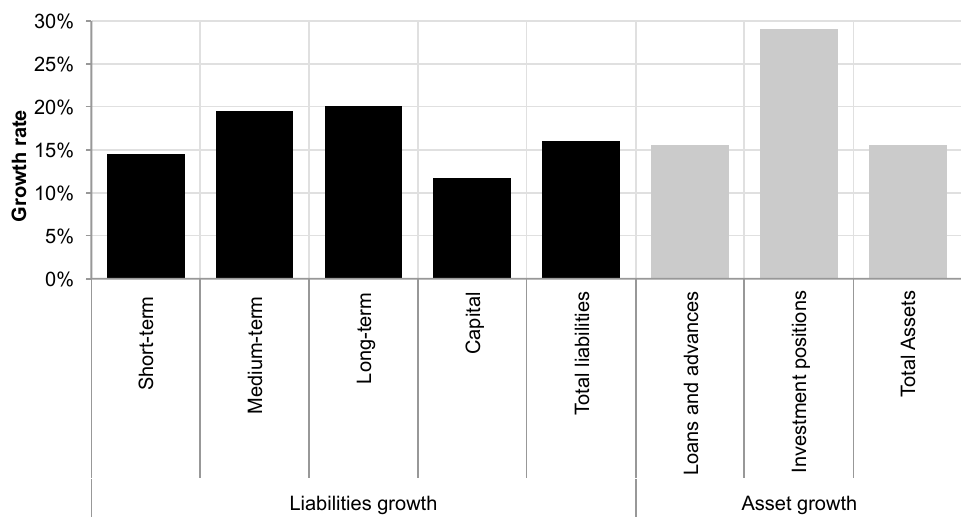
Selected liabilities and assets average growth: 2002-03–2006/07.